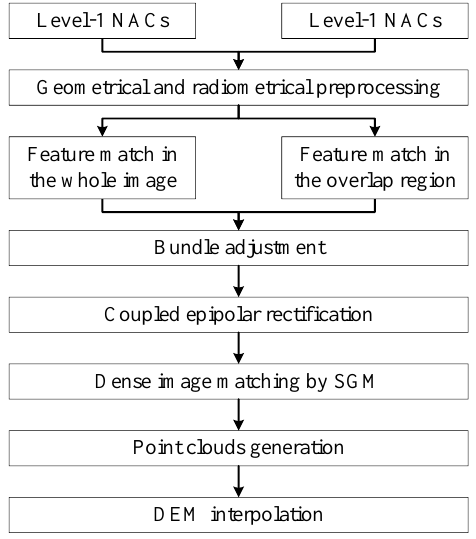
Figure 2. Workflow of the methods.